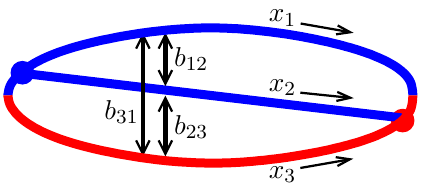
Figure 8 . The hard splitting rate diagram, with emphasis on the three different transverse separations b ij . The longitudinal momentum fraction labels ( x 1 , x 2 , x 3 ) are shown for later